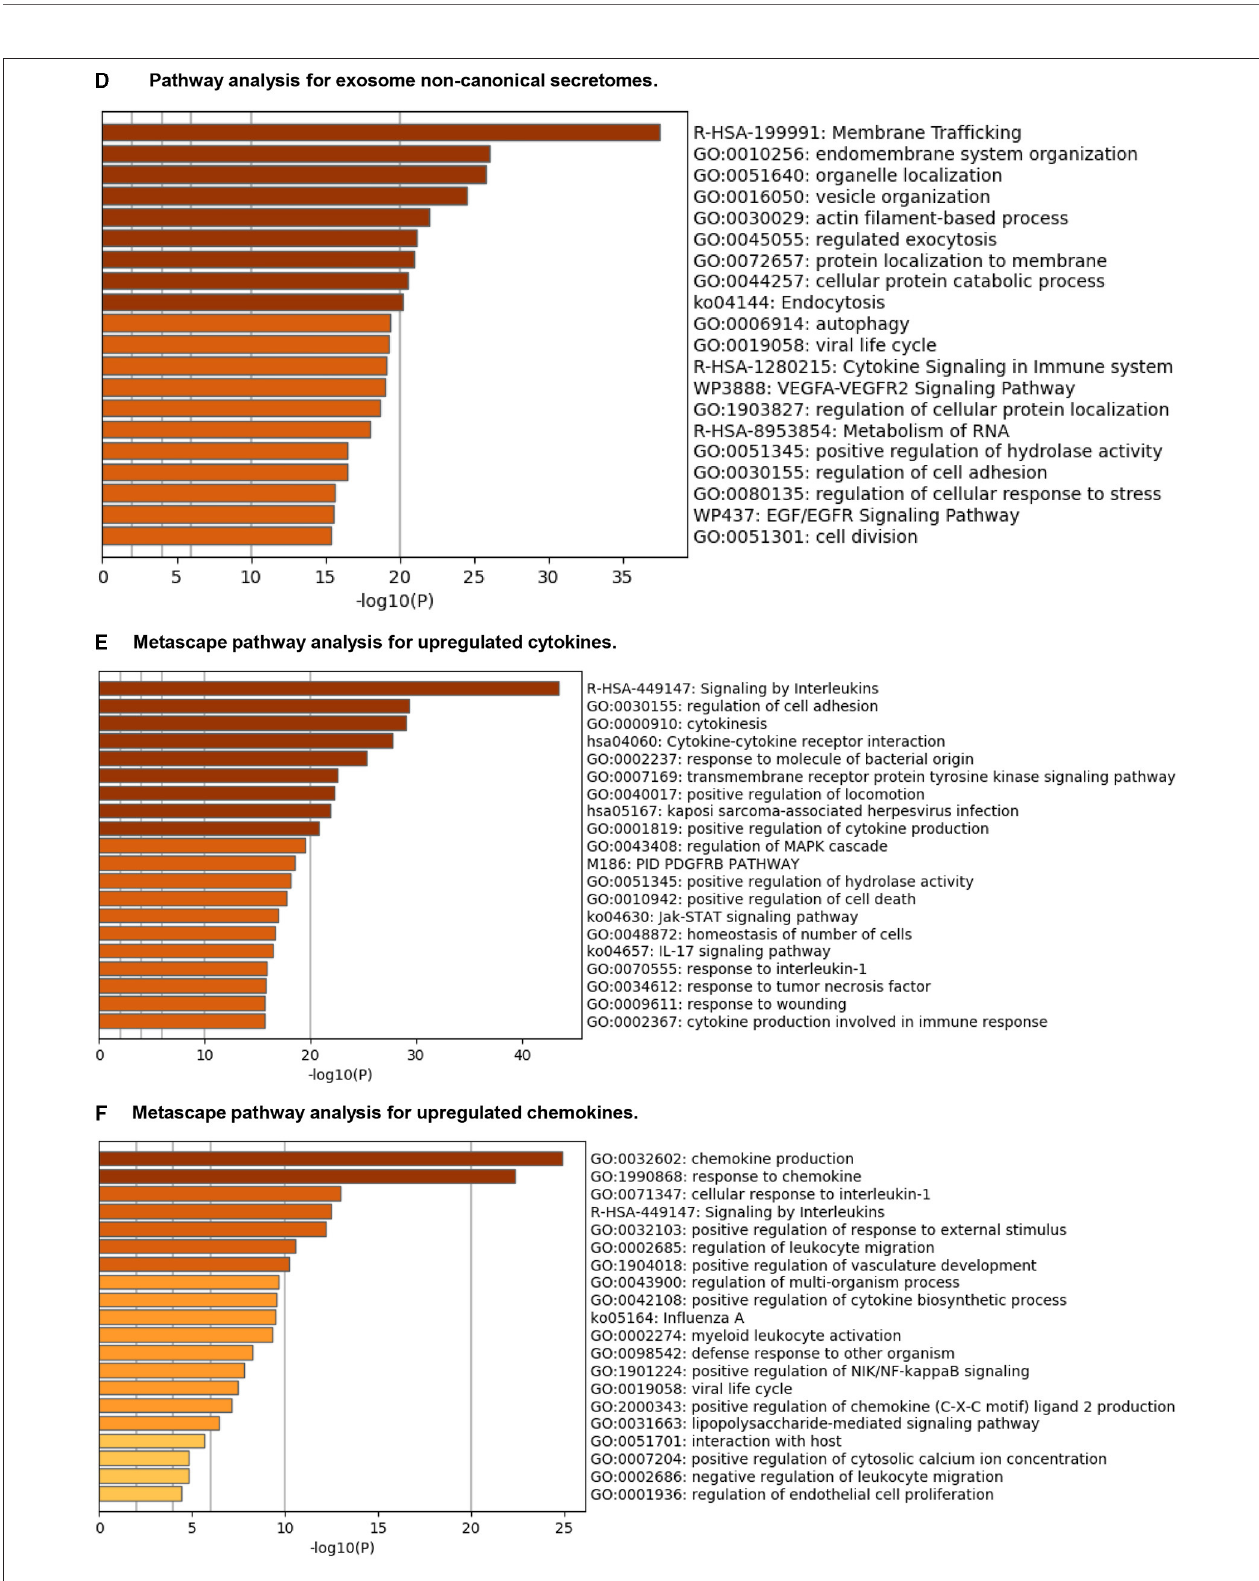
FIGURE 6 | Metascape pathway analysis for upregulated six secretomes and cytokine and chemokines in LPI-treated HAECs. (A) Pathway analysis for canonical secretomes. (B) Pathway analysis for caspase-1-dependent non-canonical GSDMD secretomes. (C) Pathway analysis for caspase-4-dependent non-canonical GSDMD secretomes. (D) Pathway analysis for exosomes non-canonical secretomes. (E) Metascape pathway analysis for upregulated cytokines. (F) Metascape pathway analysis for upregulated chemokines.